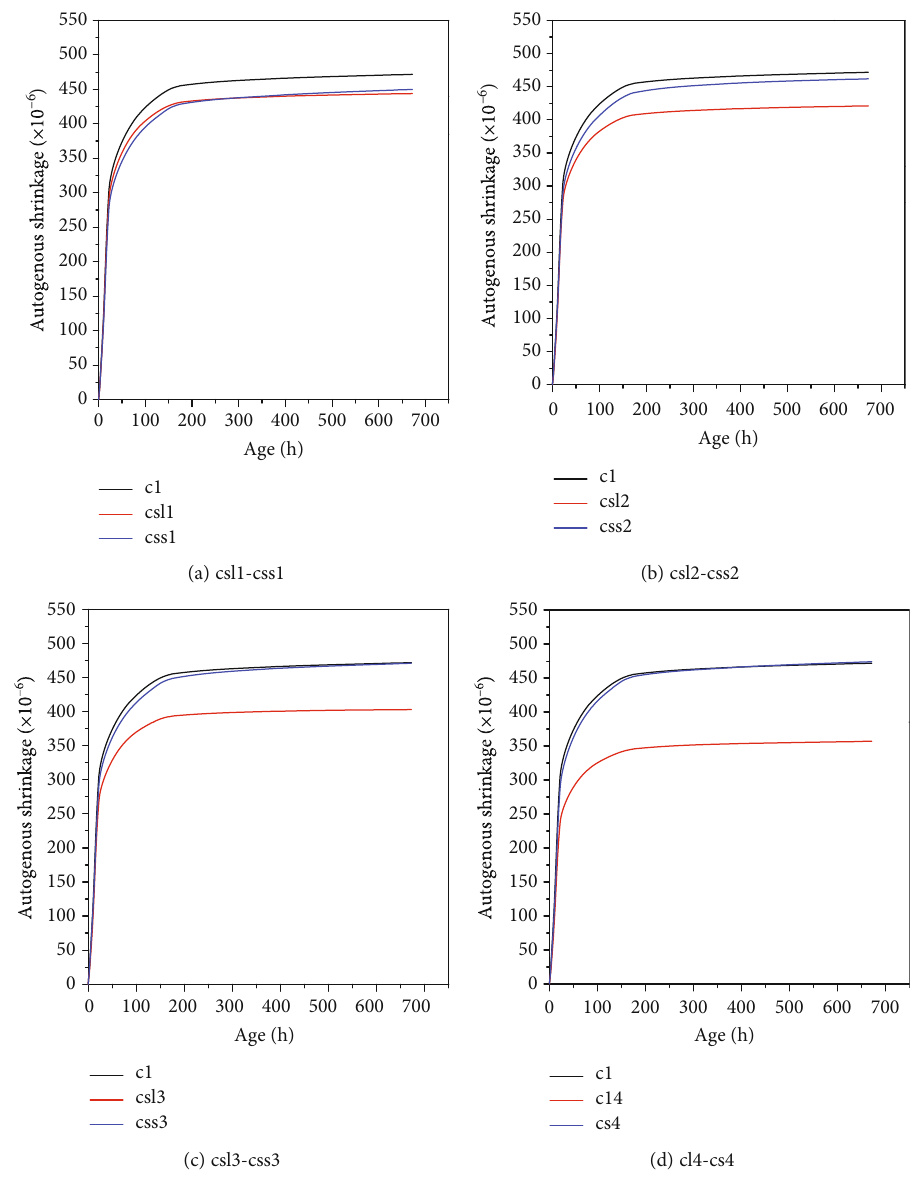
Figure 7: Comparison of autogenous